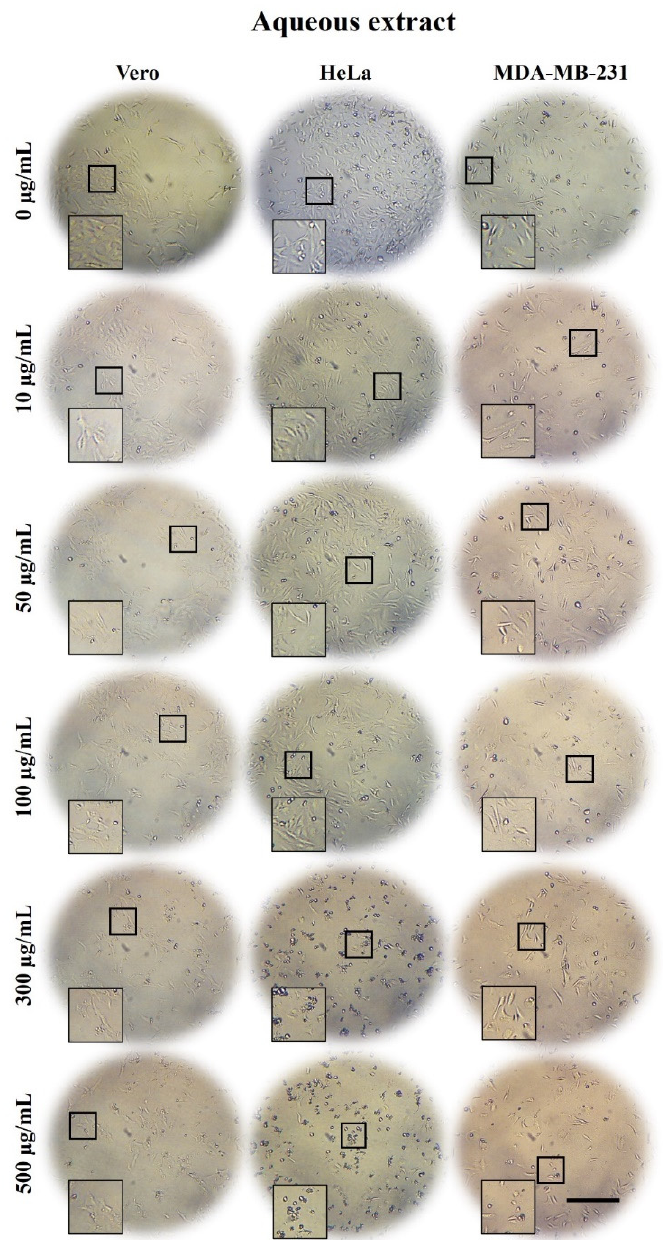
Figure 1. Micrographs of Vero, HeLa, and MDA-MB-231 cells exposed for 24 h to 0, 10, 50, 100, 300, and 500 µg/mL of A. monostachya AE. The tumor cells showed decrease confluence and morphological alterations such as rounding and loss of adhesion upon exposure to the treatments. These changes were accentuated at concentrations of 300 µg/mL and 500 µg/mL. HeLa cells showed greater changes compared to MDA-MB-231 and Vero cells, which showed minimal changes at this time point. These results were time- and concentration-dependent. Scale bar = 200 µm.